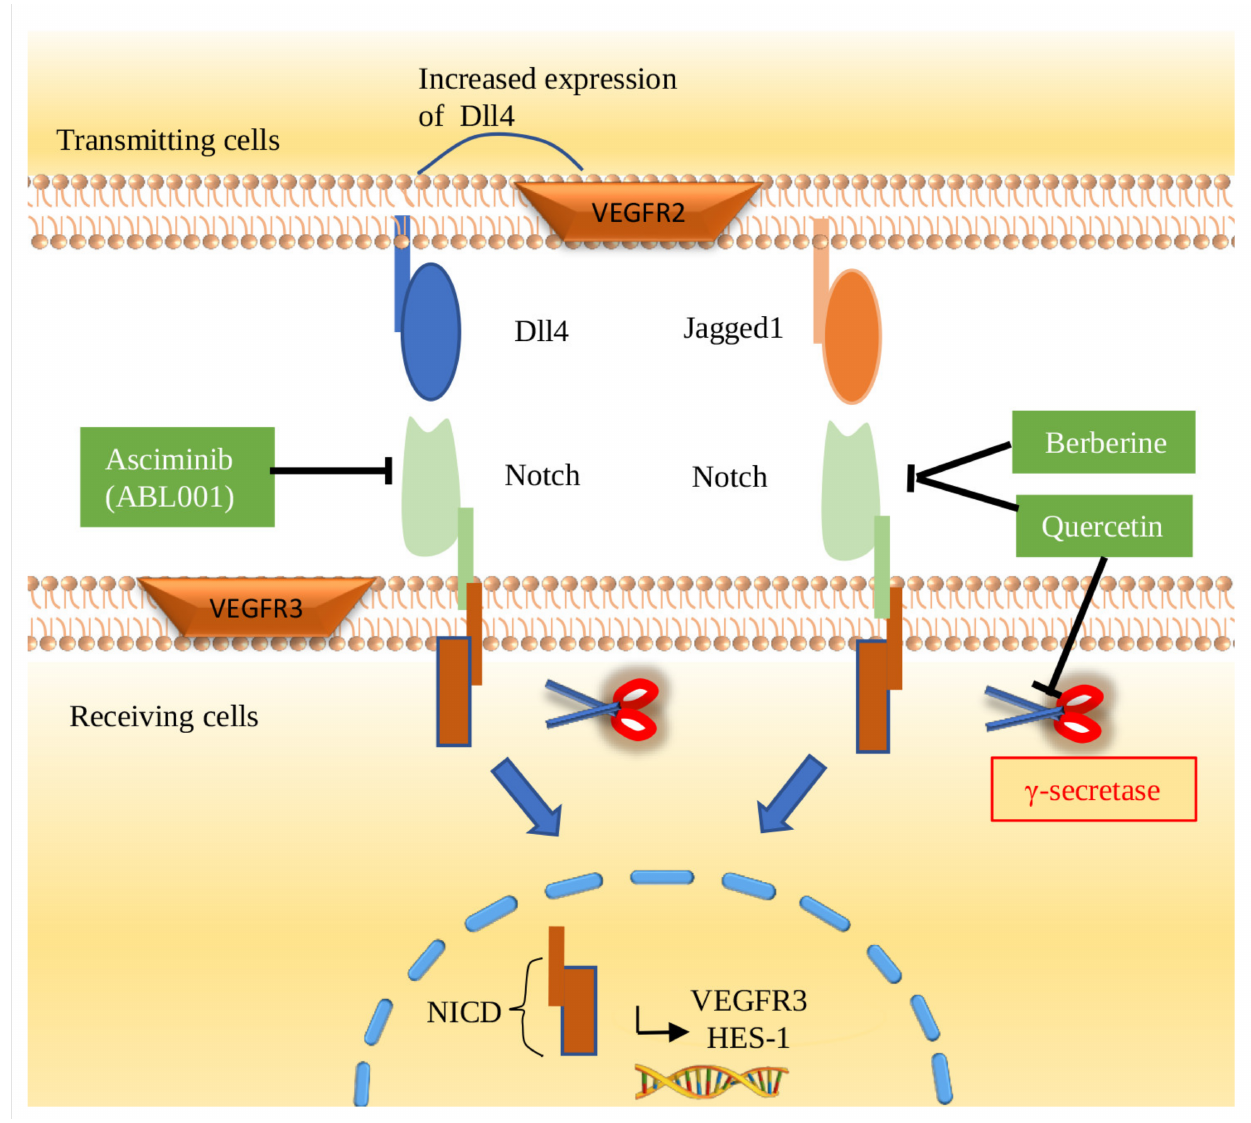
Figure 5. Regulation of angiogenesis via the Notch signaling pathway in CRC. Notch1 is a single transmembrane protein located on the cell surface that interacts with Dll4 and Jagged1 expressed on adjacent cells. As a result, γ -secretase is activated to split Notch to induce NICD into the nucleus. Then, VEGFR3 and HES-1 are upregulated and are involved in subsequent angiogenesis in CRC. As inhibitors of the Notch pathway, ABL001, berberine, and quercetin are considered potential therapeutic agents to inhibit angiogenesis in